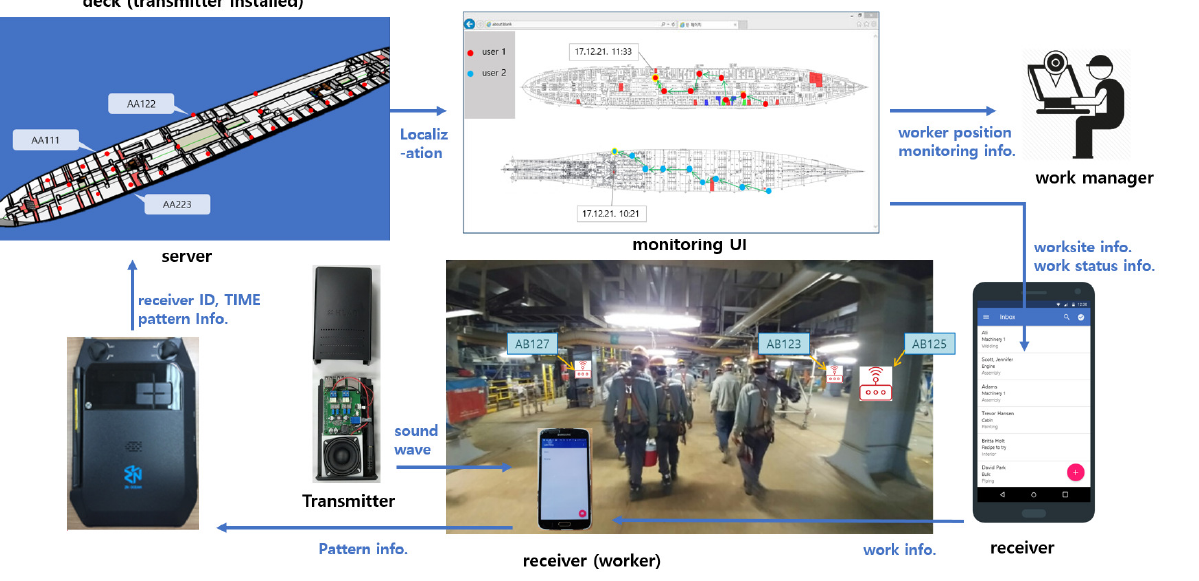
Figure 3. Operational scenario.